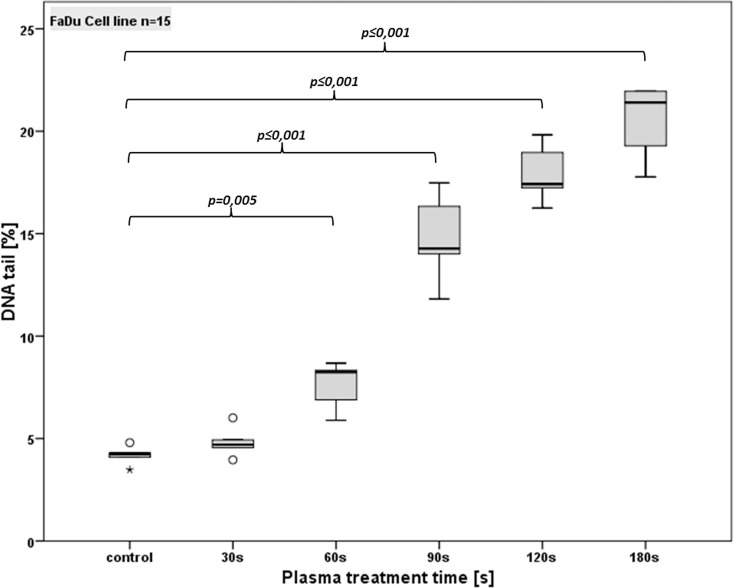
Detection of DNA damage (using the comet assay) in FaDu cells after different CAP treatment times.Standard box-plots (lower quartile, median, upper quartile) were used to illustrate the results. Dots denote mild statistical outliers (between 1.5 and 3 times interquartile range (IQR)); asterisks denote extreme statistical outliers (more than 3 times IQR).